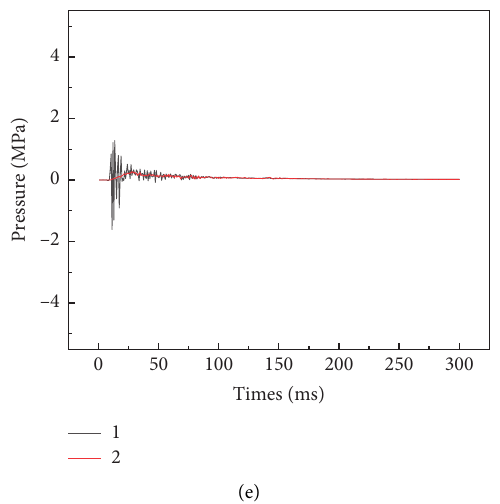
Figure 11: Pressure-time curve at different distance from charge. (a) 3m. (b) 5m. (c) 8m. (d) 10m. (e) 15m. Table 7: Statistical table of peak values of measuring points. Distance from bomb (m)